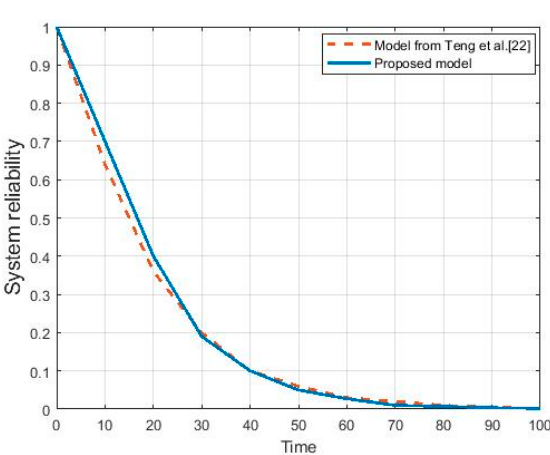
Figure 2. System reliability prediction by the proposed model and model developed in Teng et al. [22].